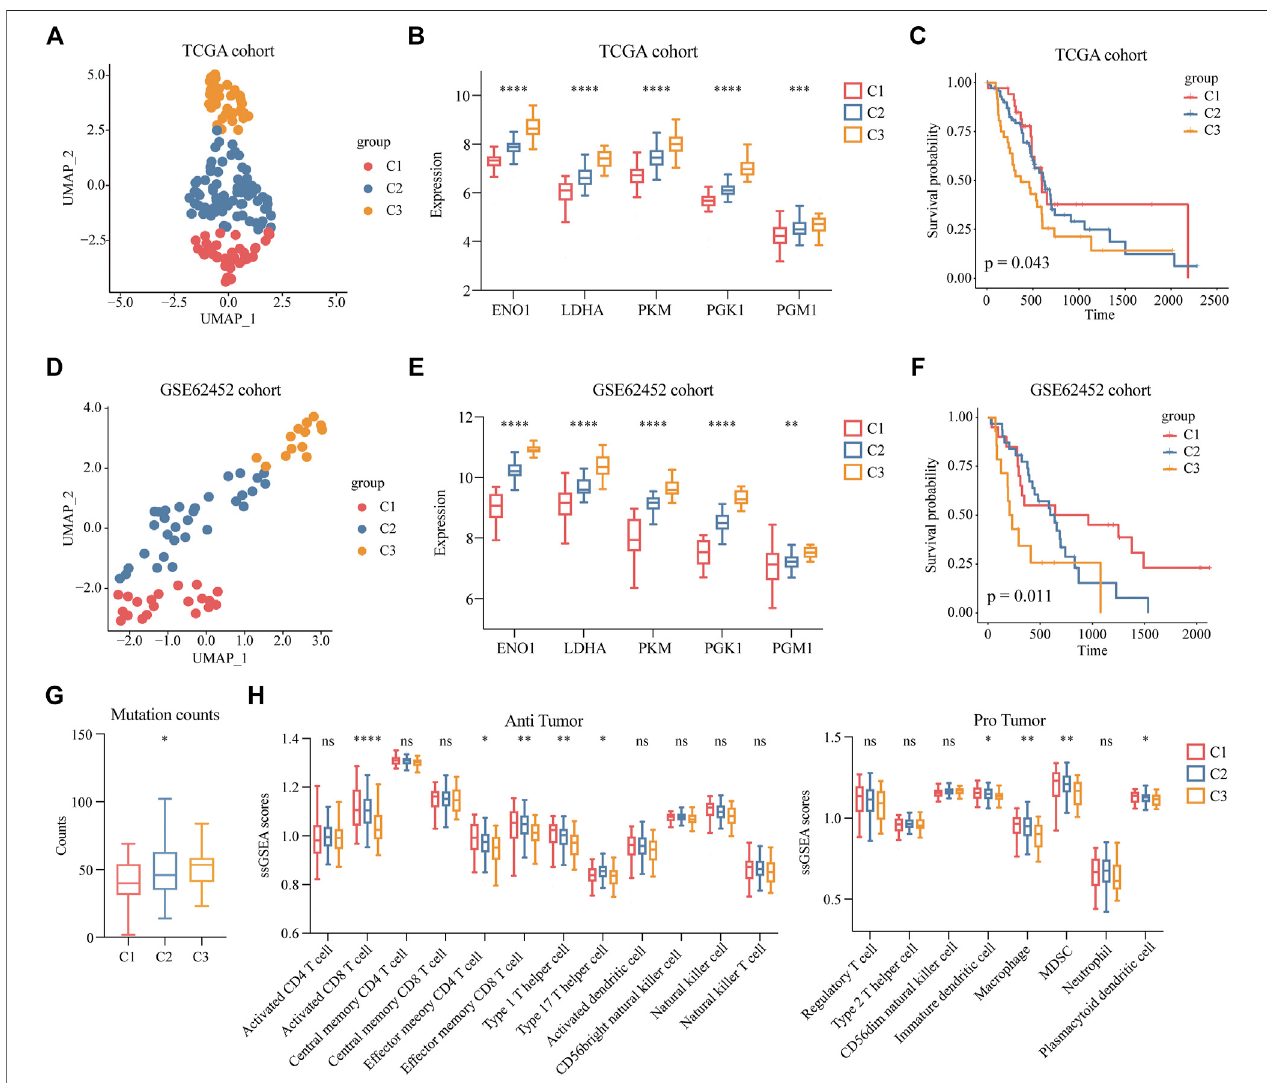
FIGURE 5 | Clinical features of patients with highly malignant cell subpopulation. (A) UMAP plot of fi ve glycolytic marker genes expression values based on the TCGAcohort and divided into clustersC1, C2, and C3. (B) Expression levels of fi ve glycolytic marker genesin groups C1(low expression), C2(median expression), and C3(highexpression)amongTCGAcohort. (C) OverallsurvivalofC1,C2,andC3groupsinTCGAcohort. (D) UMAPplotof fi veglycolyticmarkergenesexpressionvalues based on the GSE62452 cohort and divided into clusters C1, C2, and C3. (E) Expression levels of fi ve glycolytic marker genes in groups C1 (low expression), C2 (medianexpression),andC3(highexpression)amongtheGSE62452cohort. (F) OverallsurvivalofC1,C2,andC3groupsinGSE62452cohort. (G) Comparisonsofthe counts of mutations in groups C1, C2, and C3. (H) In fi ltration scores of anti-tumor and pro-tumor immune cells in C1, C2, and C3 groups. * p < 0.05; ** p < 0.01; *** p < 0.001; **** p <